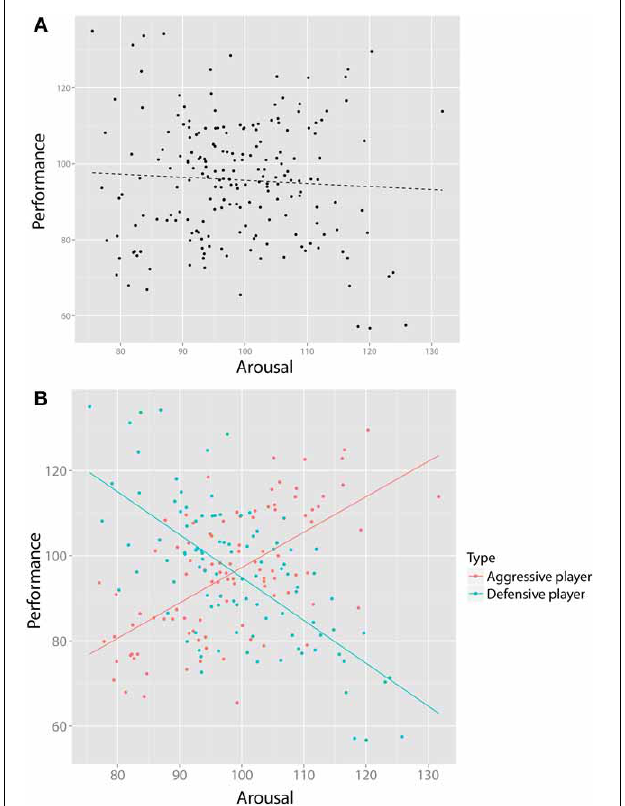
FIGURE 3 | Visualization alone does not always suffice. (A) shows the bivariate relationship between arousal and performance of tennis players, suggesting no relationship. However, after collecting new data on playing styles (e.g., how many winning shots, how many errors) we perform a cluster analysis yielding two types of players (“aggressive” and “defensive”). By including this new, bivariate variable, two clear and opposite relationships (B) emerge that would have gone unnoticed